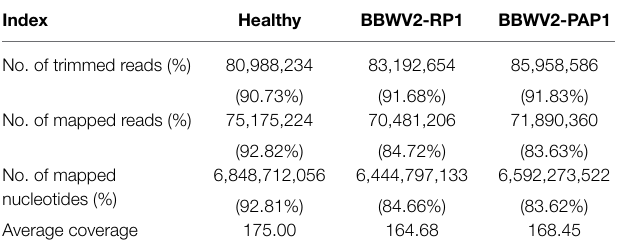
TABLE 1 | Read statistics for RNA sequencing of pepper plants infected with broad bean wilt virus 2 (BBWV2)-RP1 or PAP1. Index Healthy BBWV2-RP1